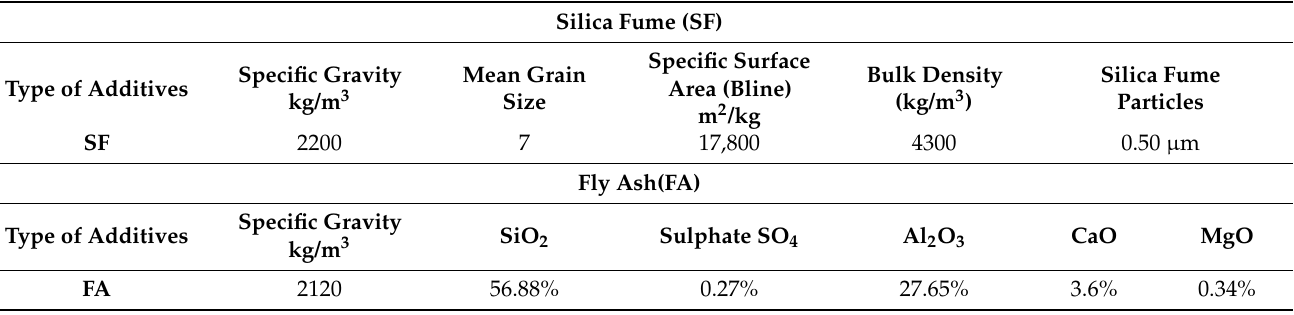
Table 3. The properties of silica fume (SF) and Fly Ash(FA) from the manufacturer data